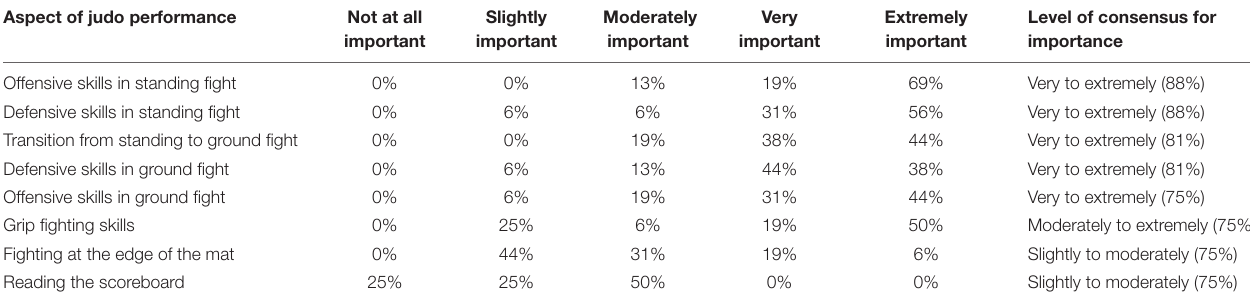
TABLE 4 | Relative importance of different aspects of judo